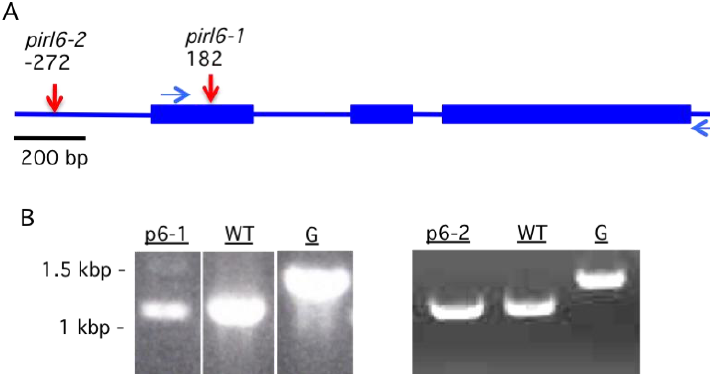
PIRL6 gametophyte function will require targeted gametophyte-specific gene knockdown in transgenic plants, tilling for non-lethal point mutations, or fortuitous identification of less severe mutant alleles in a forward genetic screen. Figure 4. PIRL6 gene structure, T-DNA insertion alleles, and knockout status. ( A ) The PIRL6 locus (At2g19330), with exons shown as blue rectangles, introns and flanking regions as lines. Positions of T-DNA insertions in putative knockout mutants pirl6-1 (SAIL574A05) and pirl6-2 (WISCDSLOX393-396L14) are indicated by arrows. Horizontal arrows indicate positions of RT-PCR primers used for part B; ( B ) Detection of PIRL6 transcripts in pirl6-1 and pirl6-2 putative T-DNA knockout lines. RT-PCR was carried out with PIRL6 -specific primers on total RNA isolated from flowers of homozygous mutant (p6-) or wild-type (WT) plants. G, PIRL6 gene (with introns) amplified from genomic DNA. RT-PCR specificity was confirmed by sequencing of gel purified reaction products.